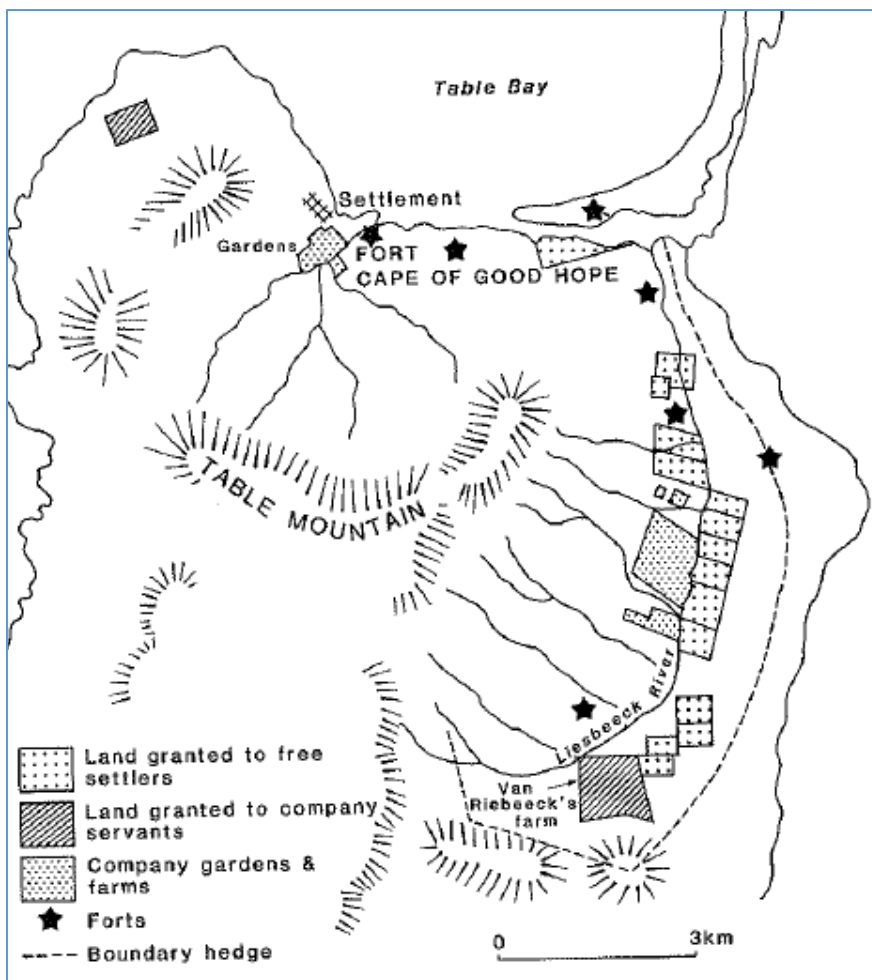
Figure 1 Map of first Dutch farms and boundary hedge at the Cape in the 1650s. (Source: Christopher, 1994: